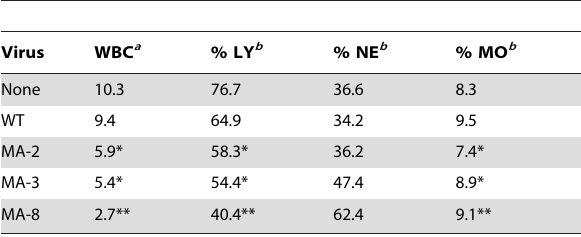
Table 3. Impact of viral infection on the mouse lymphocyte populations in whole